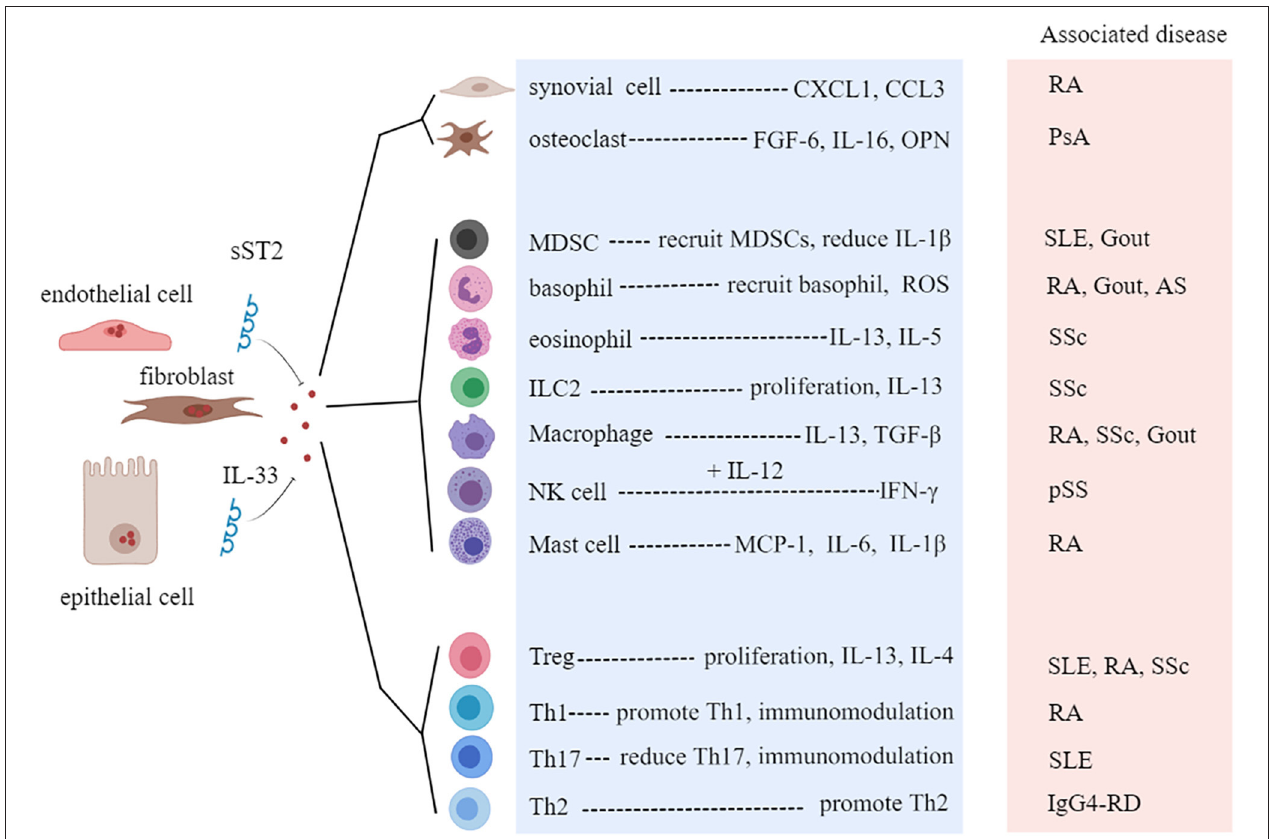
FIGURE 5 | Roles of interleukin-33 (IL-33) in rheumatic diseases. sST2, soluble ST2; CXCL1, C-X-C motif chemokine ligand 1; FGF-6, fibroblast growth factor 6; OPN, osteopontin; MDSC, myeloid-derived suppressor cell; ROS, reactive oxygen species; ILC, innate lymphoid cell; Treg, regulatory T cell; RA, rheumatoid arthritis; SLE, systemic lupus erythematosus; pSS, primary Sjögren’s syndrome; SSc, systemic sclerosis; PsA, psoriatic arthritis; IgG4-RD, IgG4-related disease; AS, ankylosing